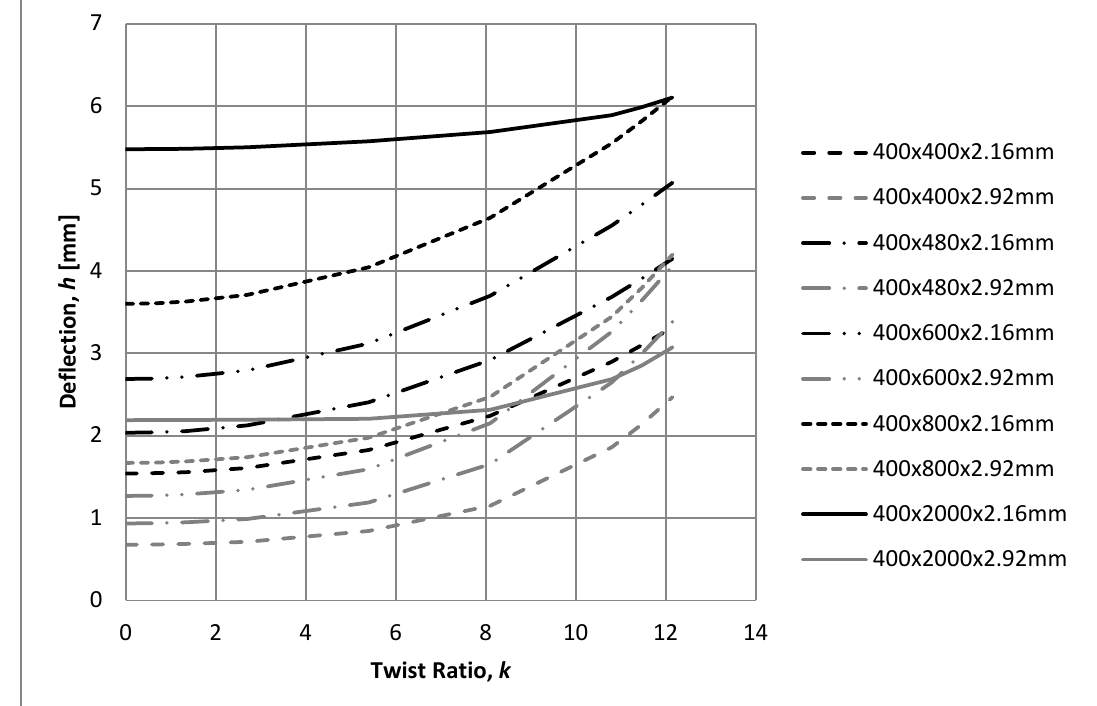
Fig. 4 Transverse deflection of 400mm wide specimens at 1.0 kPa